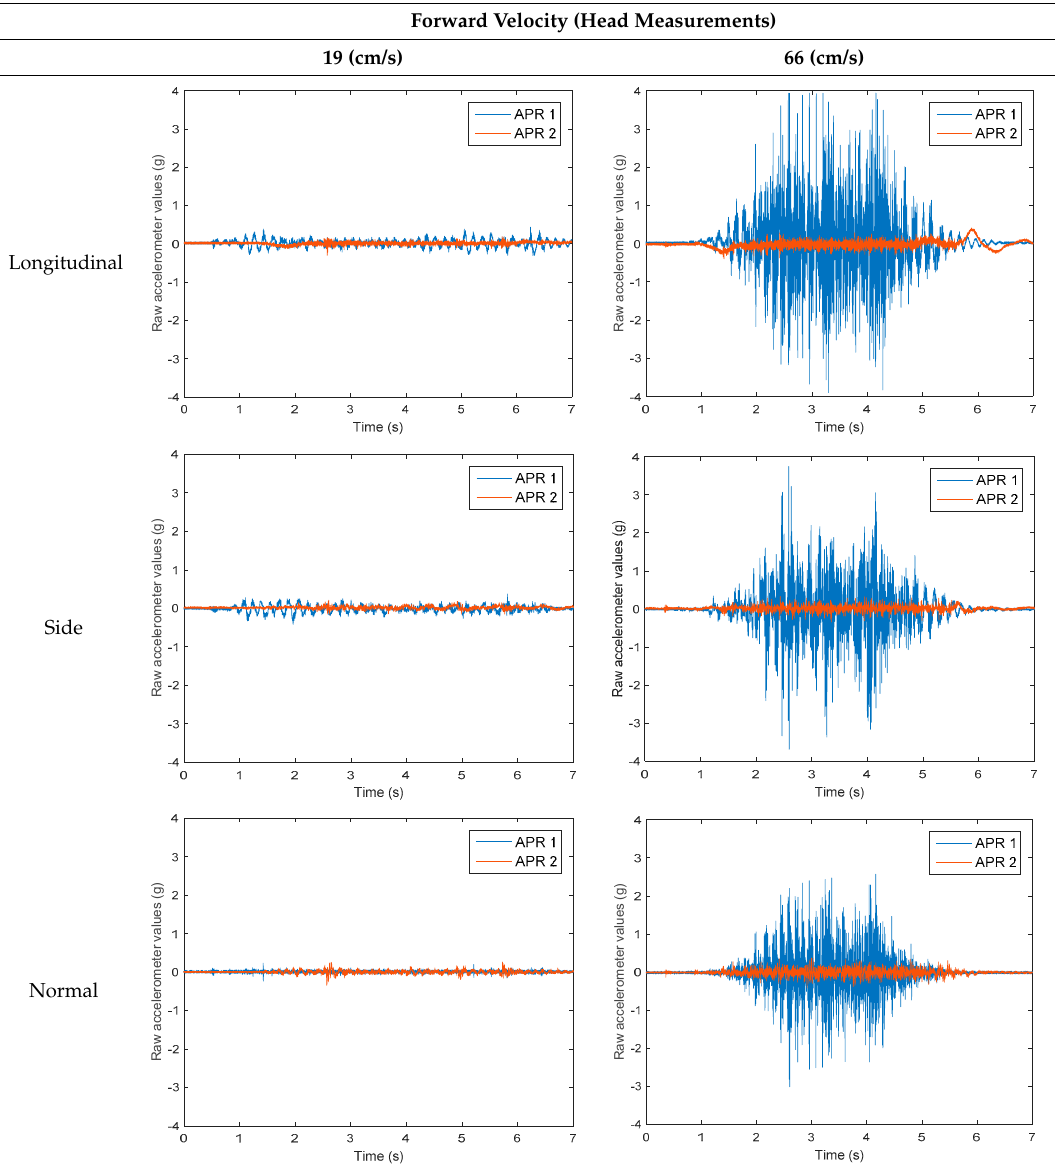
Table 5. Vibration representation measured at the head of the APR-1 and APR-2 prototypes.